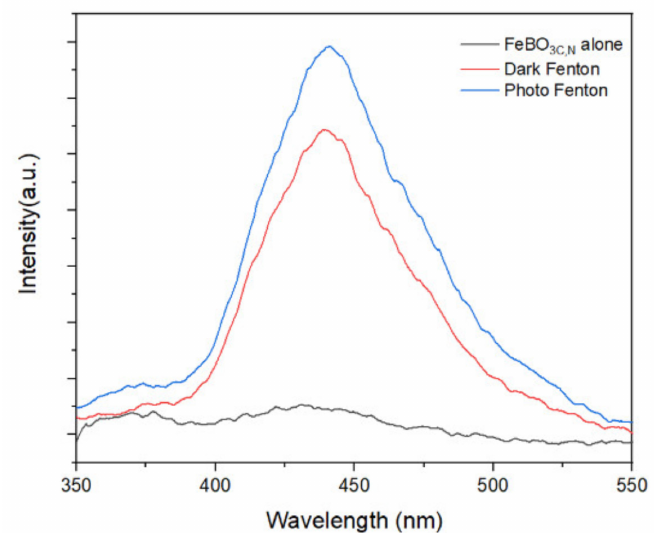
Figure 9. The TAOH fluorescence spectra of the C,N-doped FeBO 3 alone under the dark-Fenton reaction and photo-Fenton reaction for 20 min.